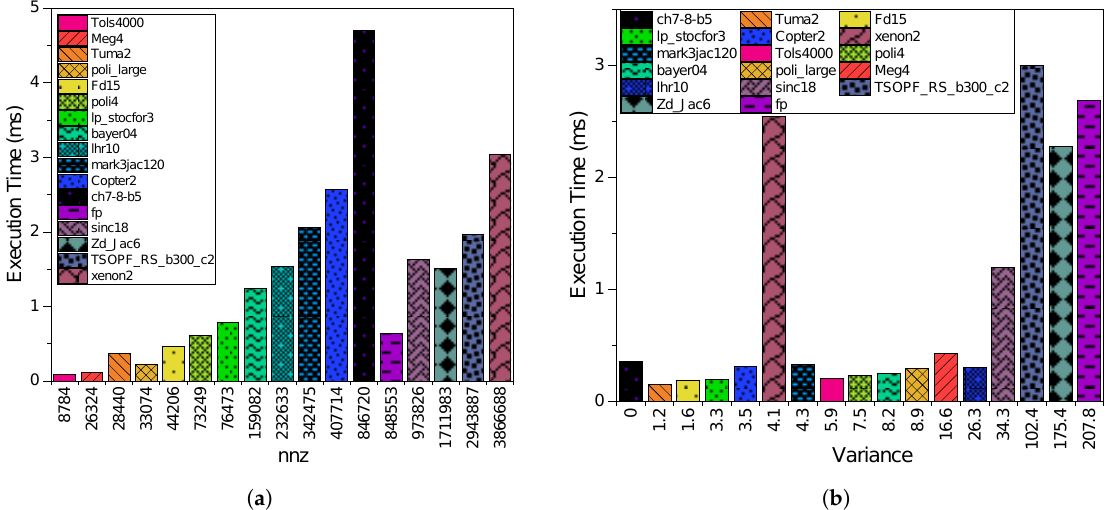
Figure 1. Compressed sparse row (CSR) execution time against: ( a ) nonzero elements in the matrices ( nnz ) and ( b ) nonzero elements per row ( npr variance